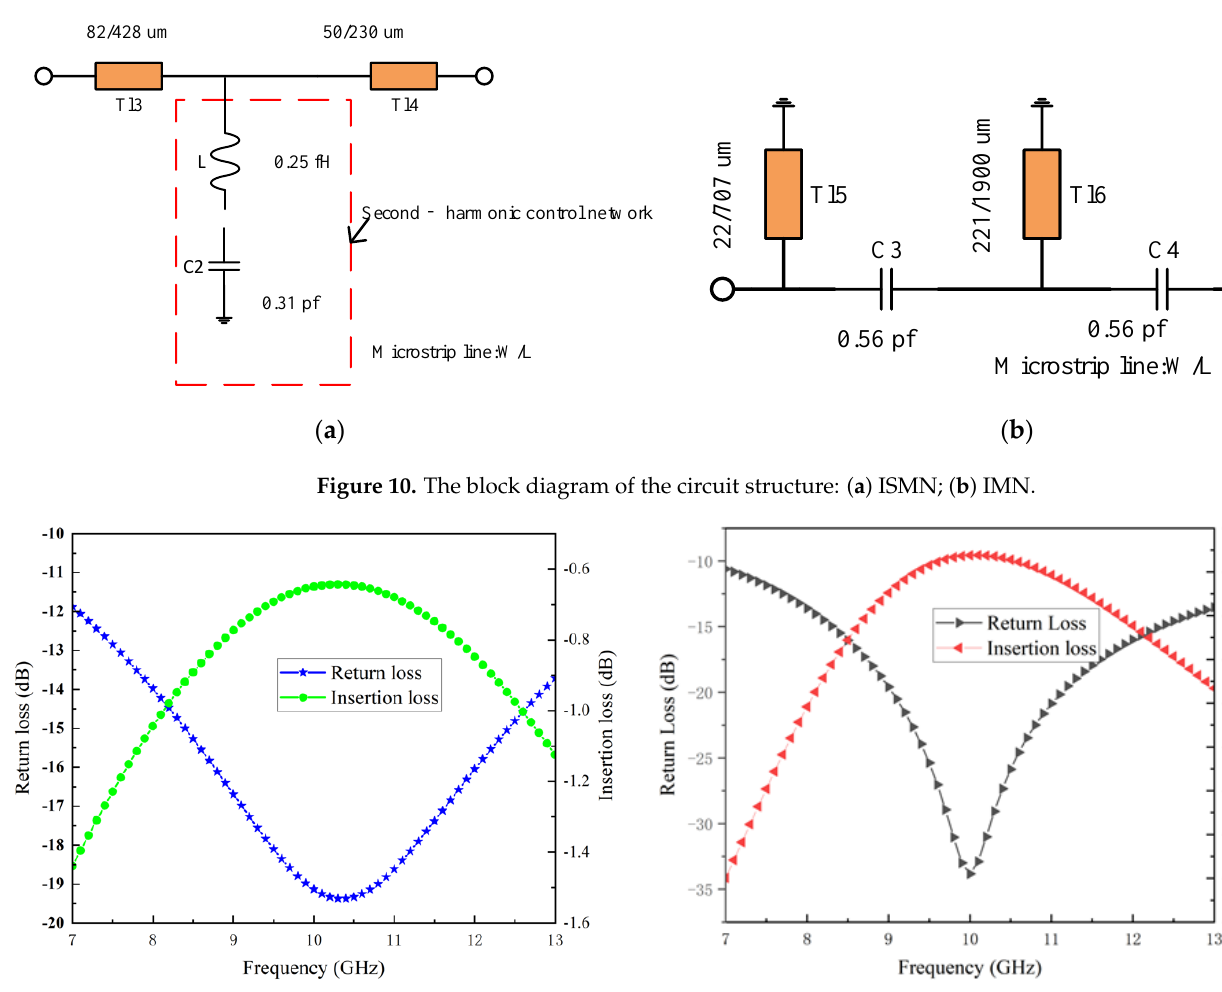
Figure 11. Return loss and insertion loss of the ( a ) ISMN; ( b ) IMN.